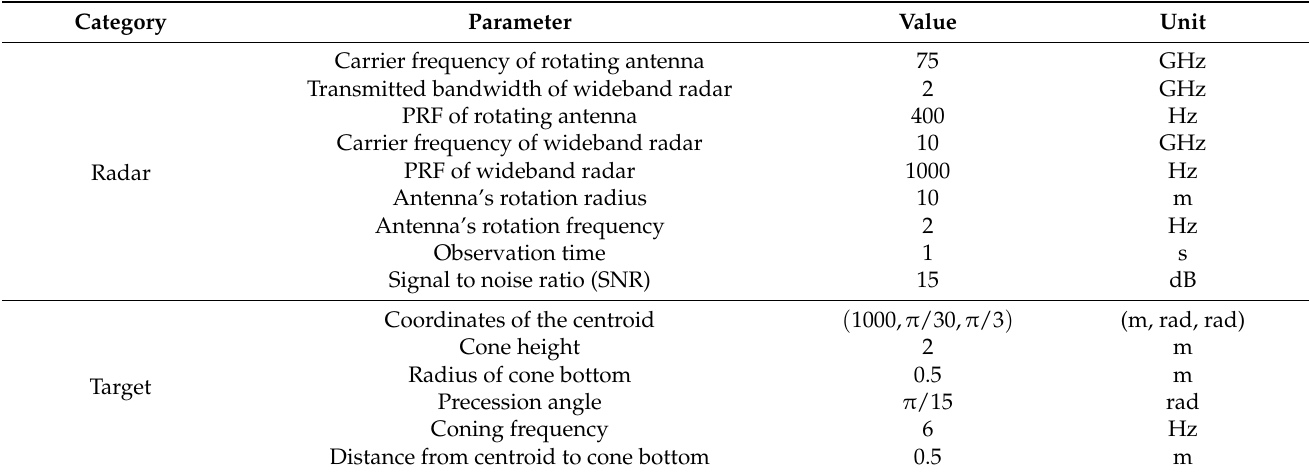
Table 1. Simulation parameters of radar and target.